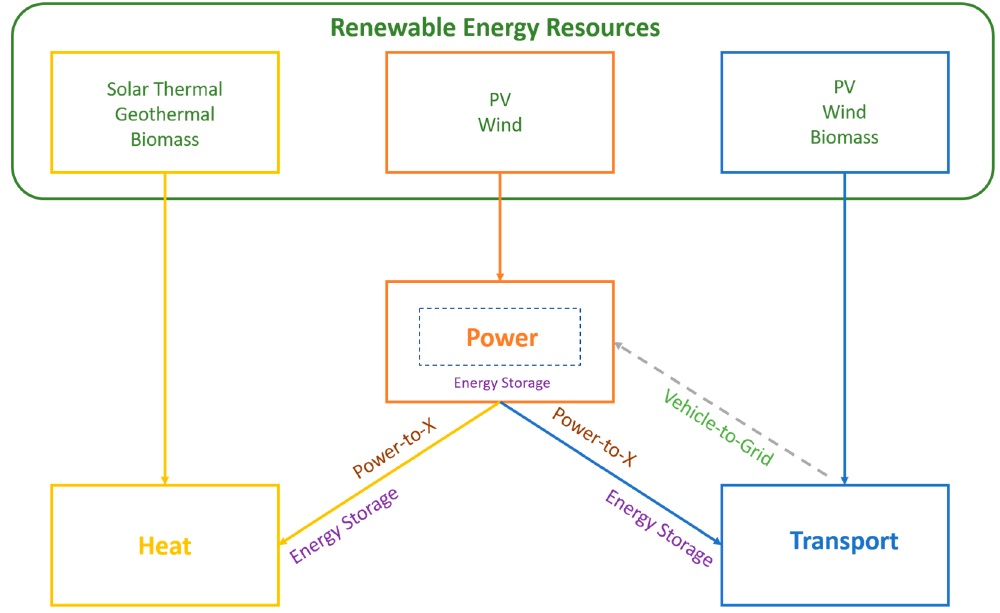
Figure 5. The idea of sector coupling between power, heat and transport sectors. Adapted from [14].